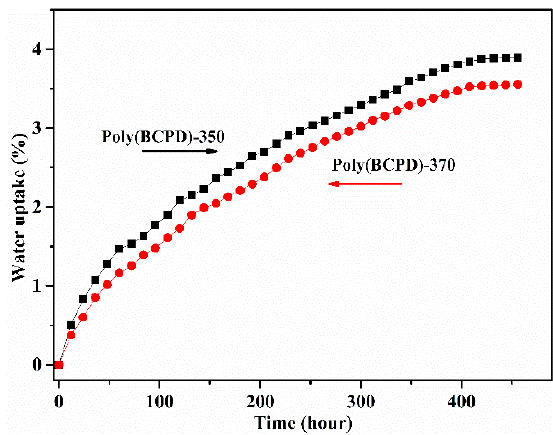
Figure 12. Water uptake curves the poly(BCPD) resins.